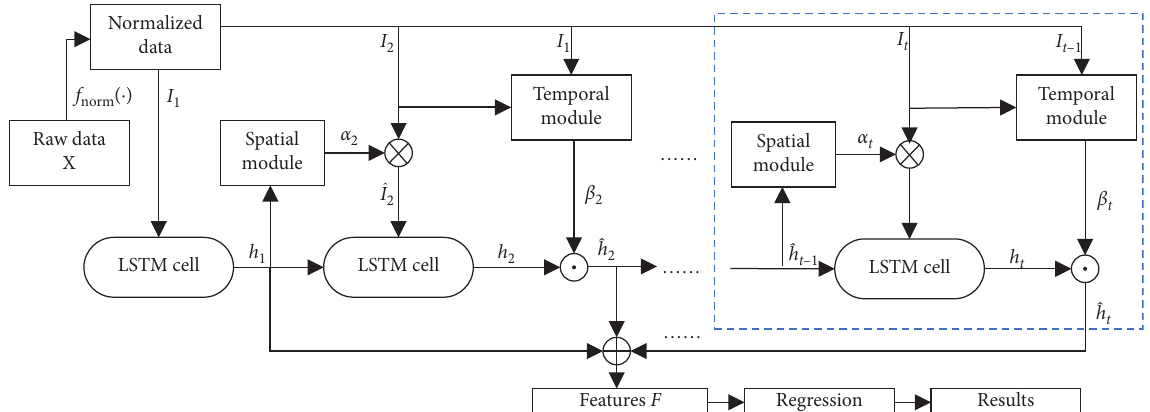
Figure 3: Network structure of the proposed STA-LSTM, which takes raw data as input and computes regression results to predict increase or decrease in run-off values. It is noted that we use blue rectangle to locate parts of STA-LSTM, which is described by equations and explanations in